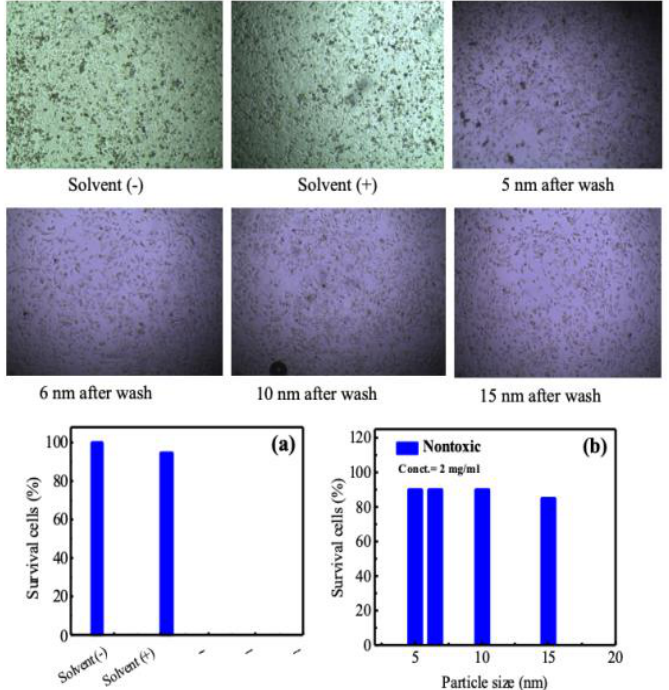
Figure 11. Cytotoxicity results assessed by survival of Hela cells ( a ) with and without solvent and ( b ) ( b ) CS-coated MnFe 2 O 4 nanoparticles at di ff erent particle sizes, where the corresponding cell culures CS-coated MnFe 2 O 4 nanoparticles at different particle sizes, where the corresponding cell culures are are pictured on the top pictured on the top panel.